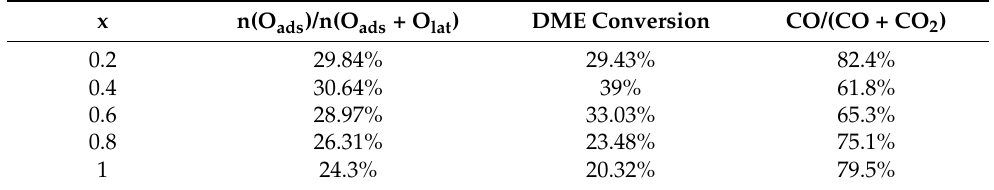
Table 3. n(O ads )/n(O ads + O lat ) and CO/(CO + CO 2 ) in Ce x Zr 1 − x O 2